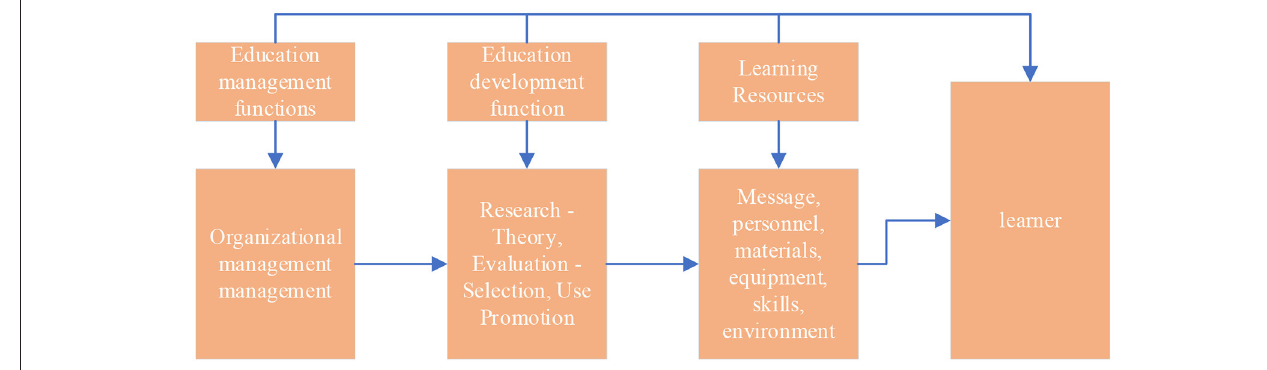
FIGURE 3 | Operational model flowchart.